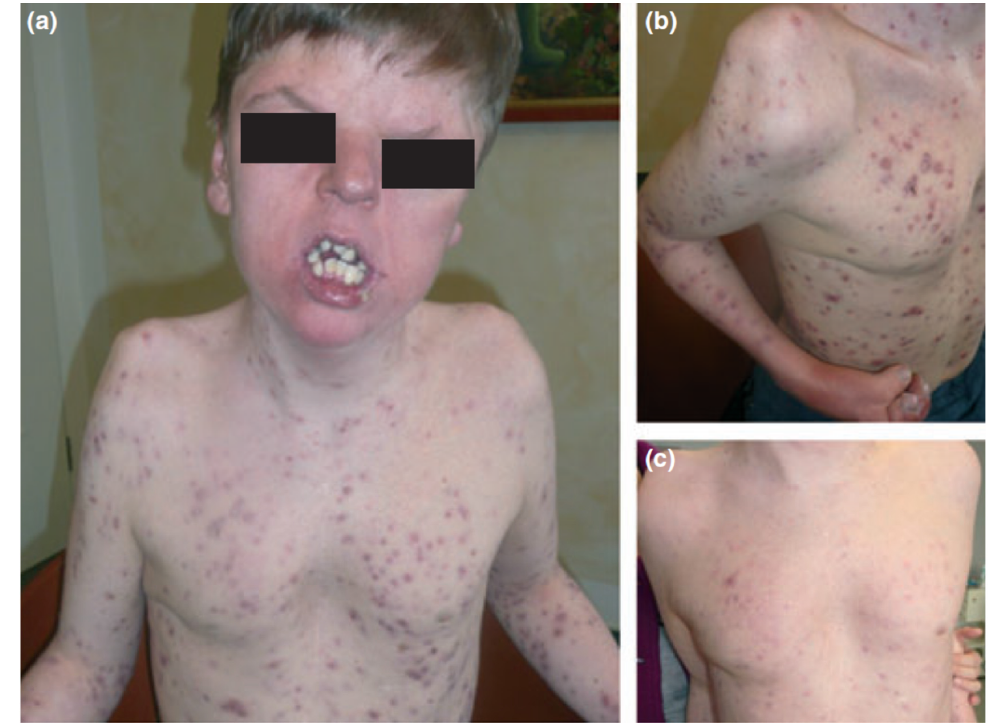
Figure 6. Apert syndrome with early onset severe nodulocystic acne ( a ) extending to the forearms and thighs with syndactyly ( b ) in a 16-year-old boy with a germ-line S252W FGFR2 mutation. ( a ) and ( b ) before and ( c ) 4 weeks after daily treatment with 40 mg isotretinoin. Reproduced from Chen et al. [87] with permission from Wiley, Hoboken, NJ, USA.